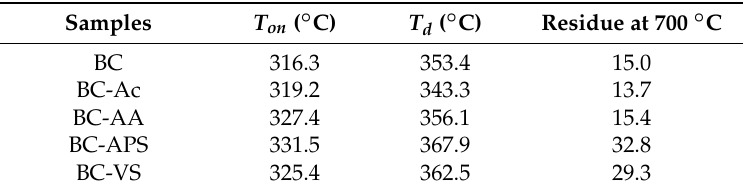
Table 3. TGA results for untreated and treated